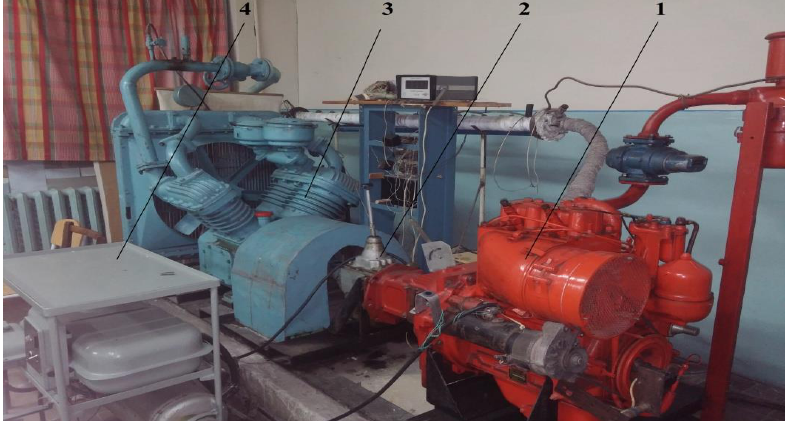
Fig. 1. Appearance of experimental stand based on the diesel engine D21A1: 1 – converted to diesel engine D21A1; 2 – transmission; 3 – compressor K-5M; 4 – air heating